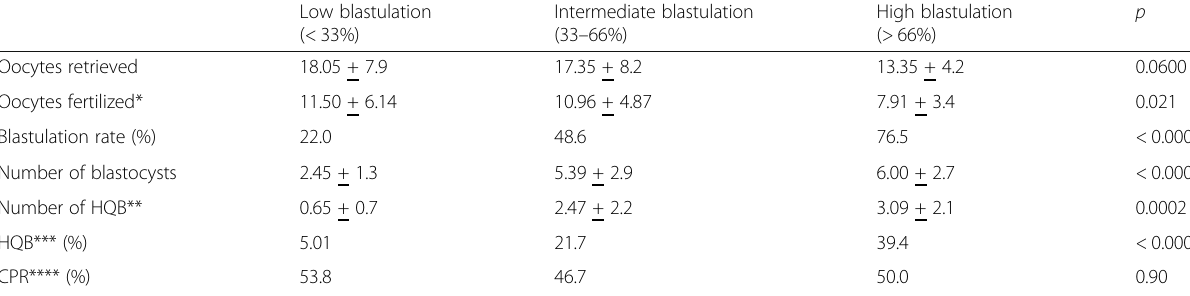
Table 5 IVF cycle outcomes by variable blastulation rates